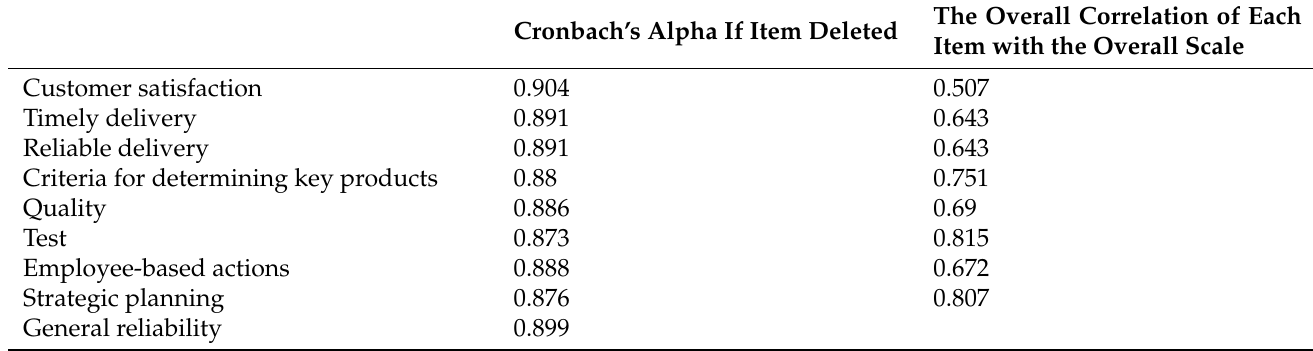
Table 10. Reliability test related to non-financial factors of management control